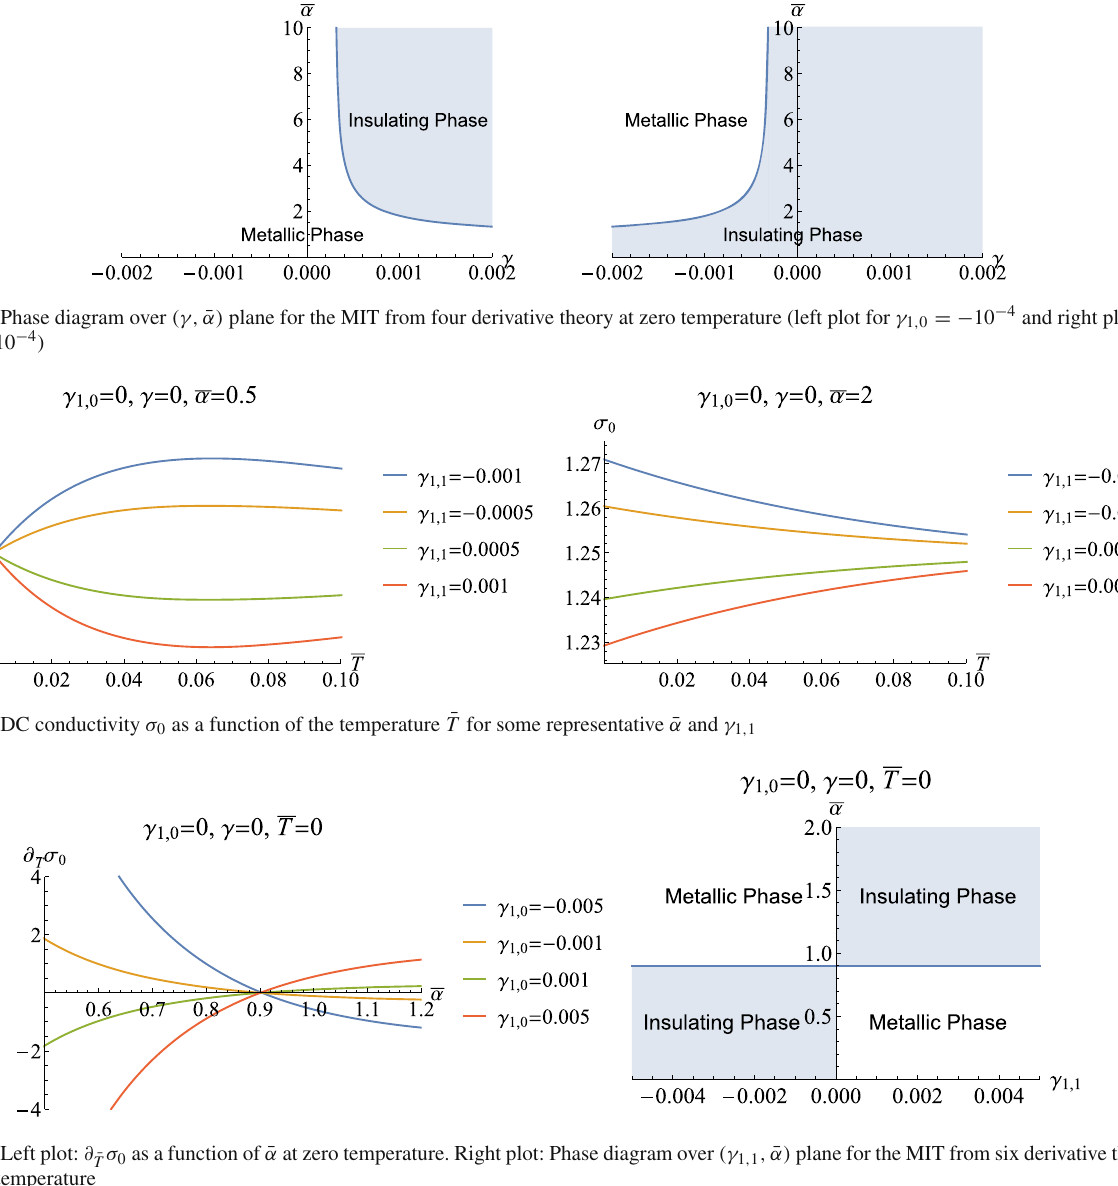
, ¯ α) plane for the MIT from six derivative theory 1 , 1